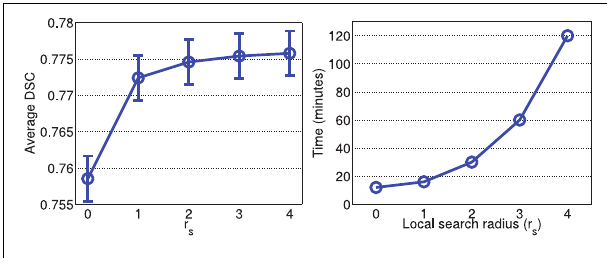
FIGURE 3 | Joint label fusion performance (Left: segmentation accuracy, error bars at ± 0.05 standard deviation; Right: average processing time) with respect to local search neighborhood size. Other parameters are set to r p = 2 , α = 0 . 1 , β = 2.